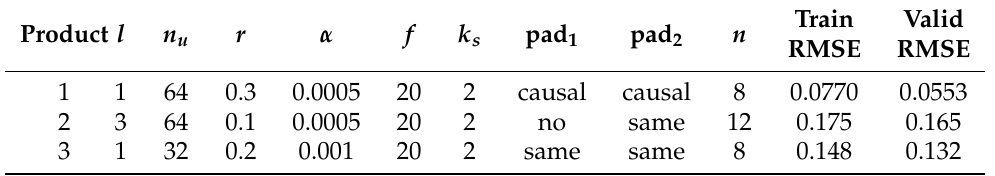
Table 8. Results of the grid search on class B (CNN +